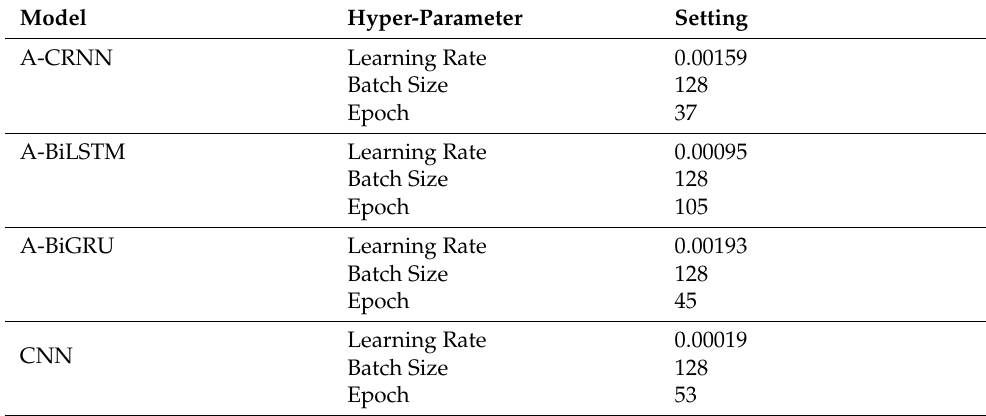
Table 9. Optimized hyper-parameter settings with respect to D1.